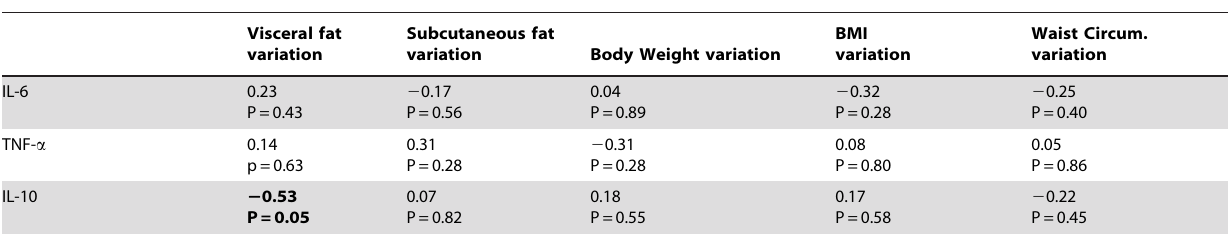
Table 4. Multivariate regression